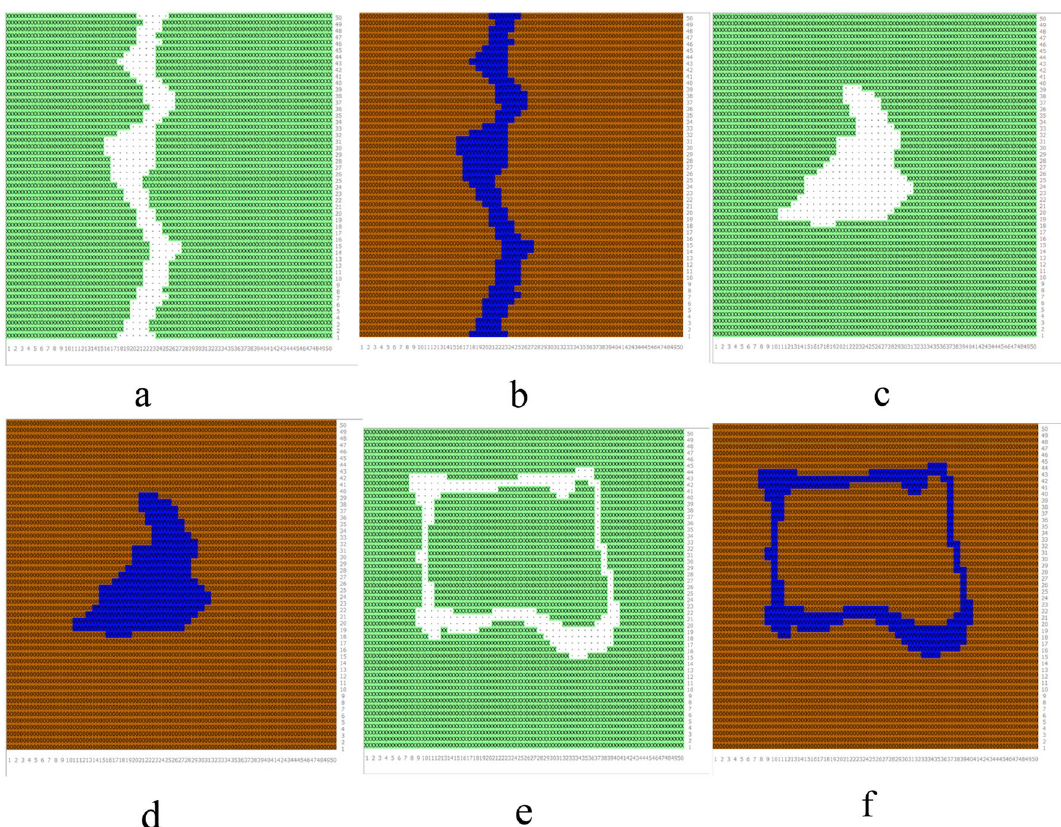
Figure 3. ENVI-met model at original site and with 5% and 10% increase of water area. ( a ) Banded water vegetation model; ( b ) Banded water soil surface model; ( c ) Massive water vegetation model; ( d ) Massive water soil surface model; ( e ) Annular water vegetation model; ( f ) Annular water soil surface model.